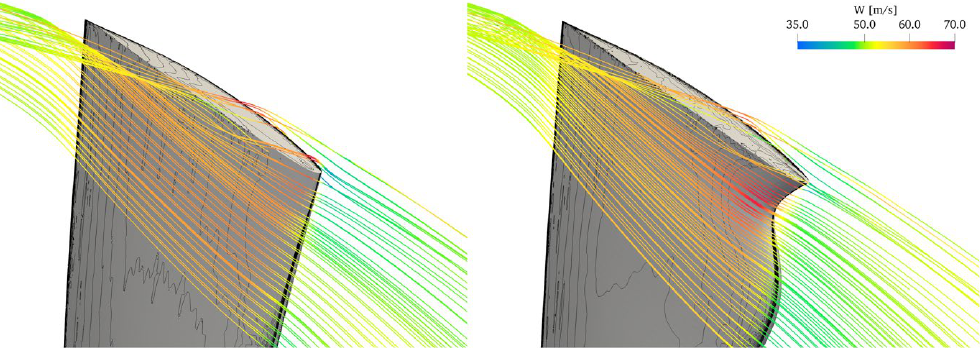
Figure 9. Relative velocity streamlines on the tip region colored with relative velocity. Left: datum; right: whaled.